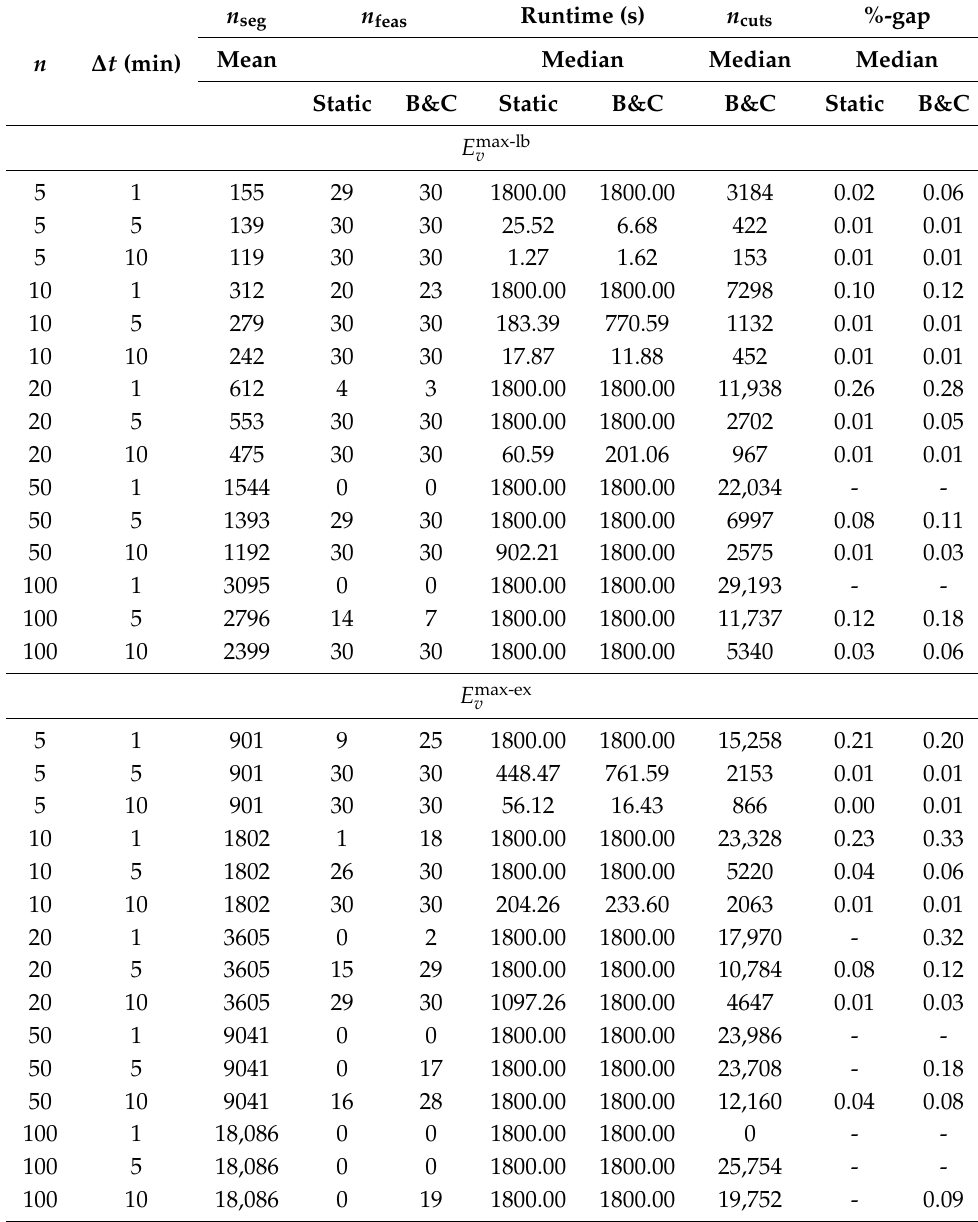
Table 4. EVS-SOC-GLIN results for solving the static model versus B&C with E max-lb v and E max-ex